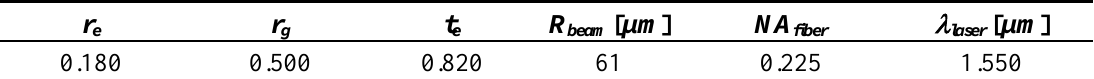
Table 1. Coefficients of reflectance ( r optical fiber, Coefficients of reflectance ( r beam ( R ), the numerical aperture of the fiber ( NA beam used in the calculation of the loss amount.